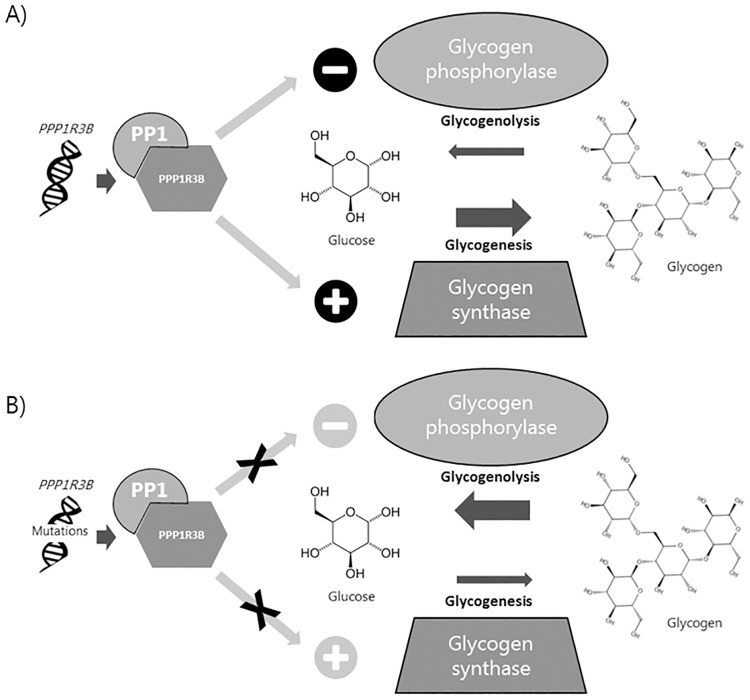
The hypothesised effect of PPP1R3B variants on glycogenesis and glycogenolysis.A) The PPP1R3B/protein phosphatase 1 (PP1) complex is an activator of glycogen synthase and an inhibitor of glycogen phosphorylase. Both functions of the PPP1R3B/PP1 complex will lead to an increase in glycogen due to increased conversion of glucose to glycogen and decreased breakdown of glycogen. B) Mutations in PPP1R3B may lead to reduced PPP1R3B/PP1 activity and consequently decreased activation of glycogen synthase and decreased inhibition of glycogen phosphorylase leading to a decreased level of glycogen.